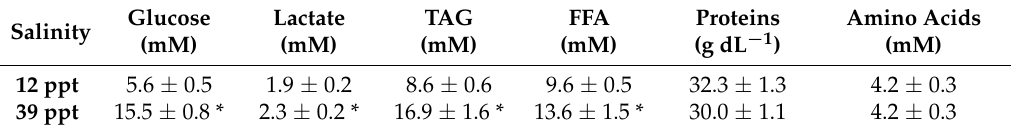
Table 2. Plasma metabolites in A. regius fingerlings acclimated to 12 and 39 ppt salinity conditions for 45 days. Data are expressed as the mean ± SEM ( n = 12). Asterisks (*) indicate significant differences among groups ( p < 0.05, Student’s t -test). TAG means triglycerides, FFA means free fatty acids.